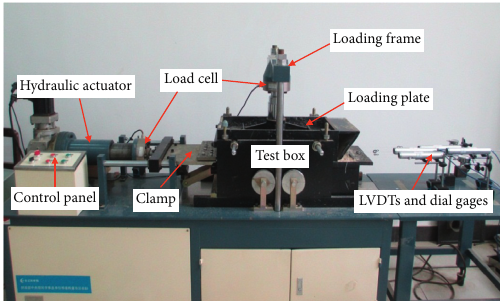
Figure 3: View of pullout test device used in this study.